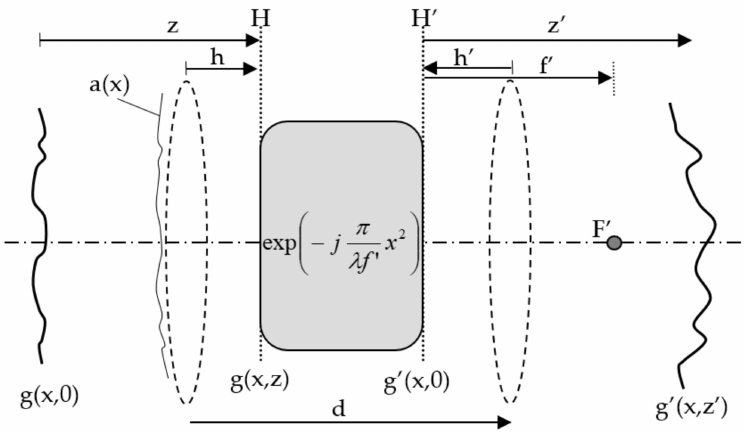
Figure 6. Diffraction-based compound system, corresponding to the architecture of Figure 4, to treat the aberration field a ( x